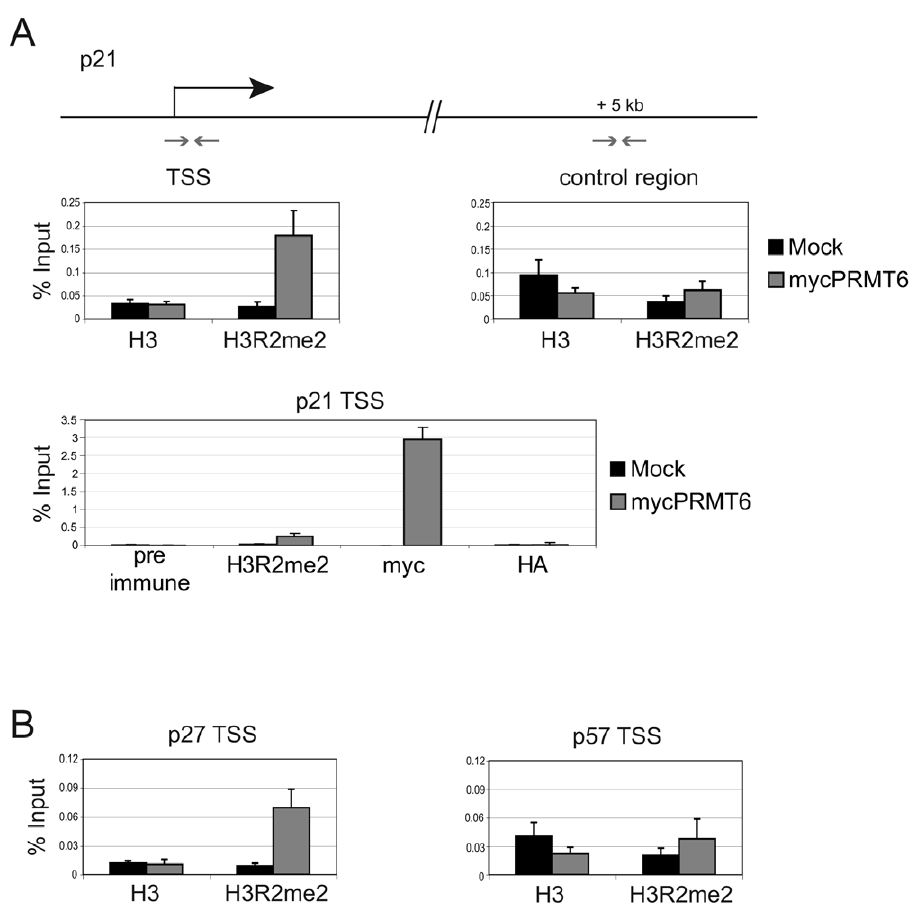
Figure 3. PRMT6 regulates p21 and p27 on the promoter level. (A) ChIP analysis was done 46 h upon transient expression of mycPRMT6 using primers for the transcriptional start site (TSS) and a control region of the p21 promoter. (B) ChIP analysis as in A, using promoter specific primers for the TSS of p27 and p57.